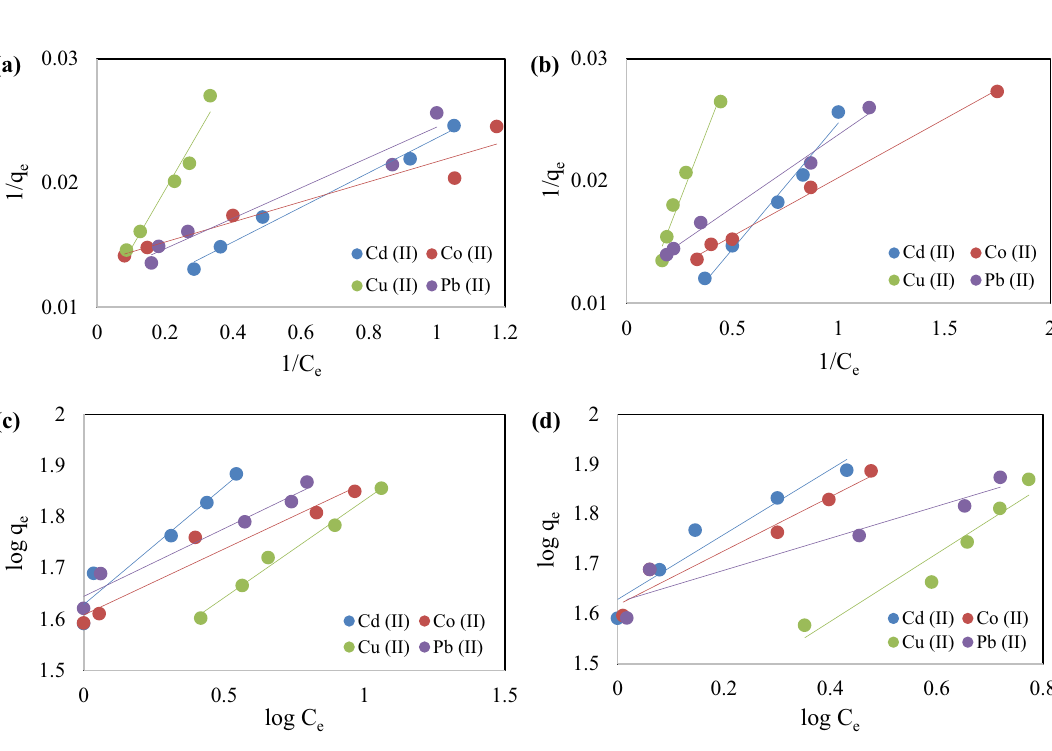
Figure 9. Linear graphs of adsorption isotherms of Cd (II), Co (II), Cu (II), and Pb (II) ions. ( a ) Langmuir’s isotherm model for TPP-CMN, ( b ) Langmuir’s isotherm model for V-CMN, ( c ) Freundlich’s isotherm model for TPP-CMN, and ( d ) Freundlich’s isotherm model for